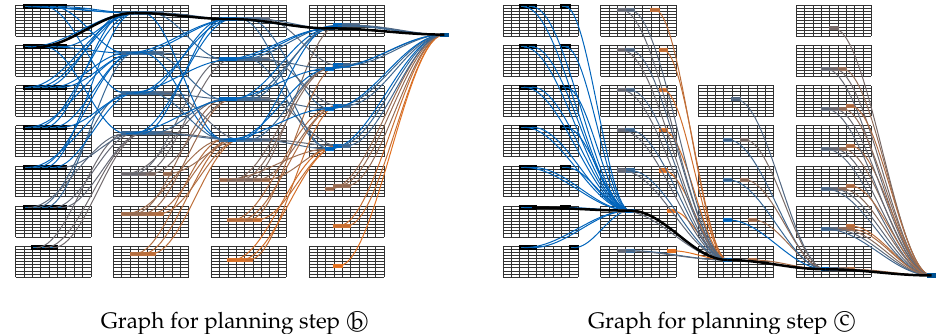
Figure 9. Comparison of graphs for defending and attacking scenarios: 450 edges were generated while overtaking in planning step b (cid:13) and 162 edges were generated while being overtaken in planning step c (cid:13) . The colors and grids are defined analogously to Figure